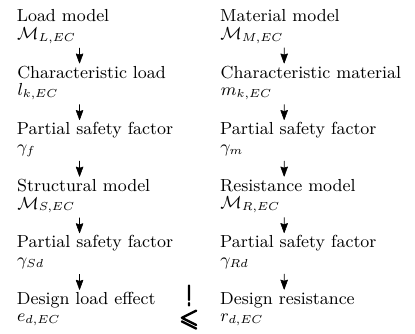
Figure 1. Overview of the Eurocode design